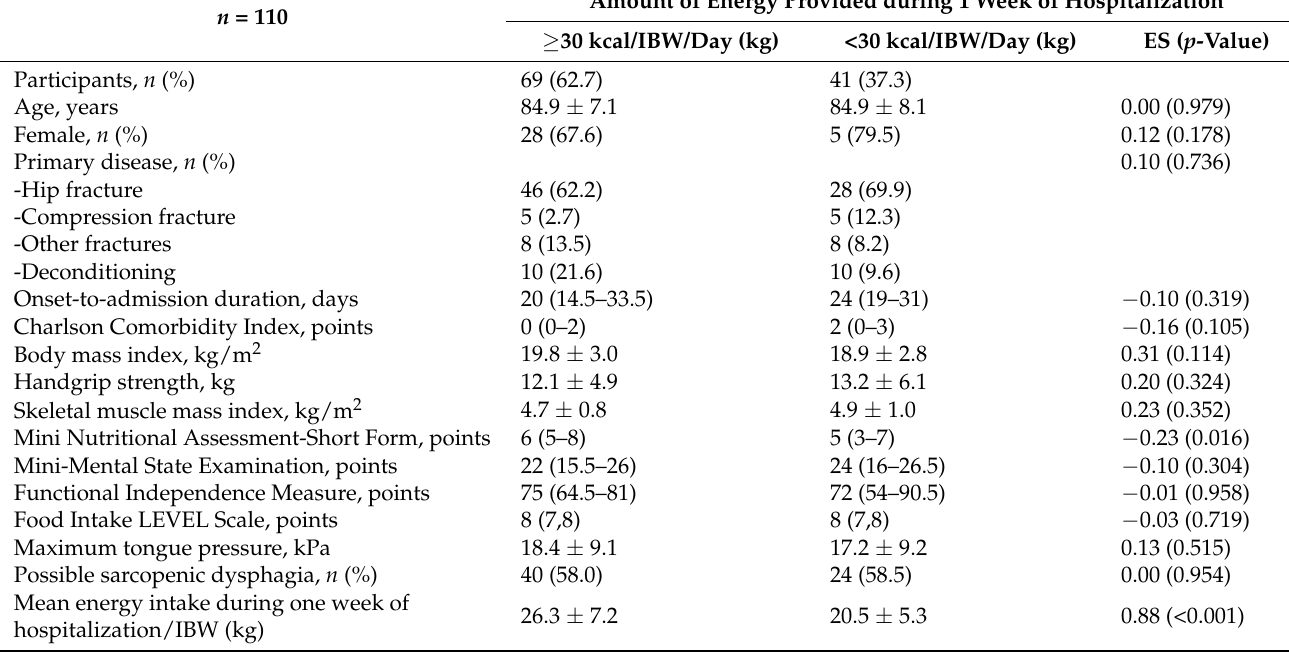
Table 1. Comparison of baseline variables in the crude population.